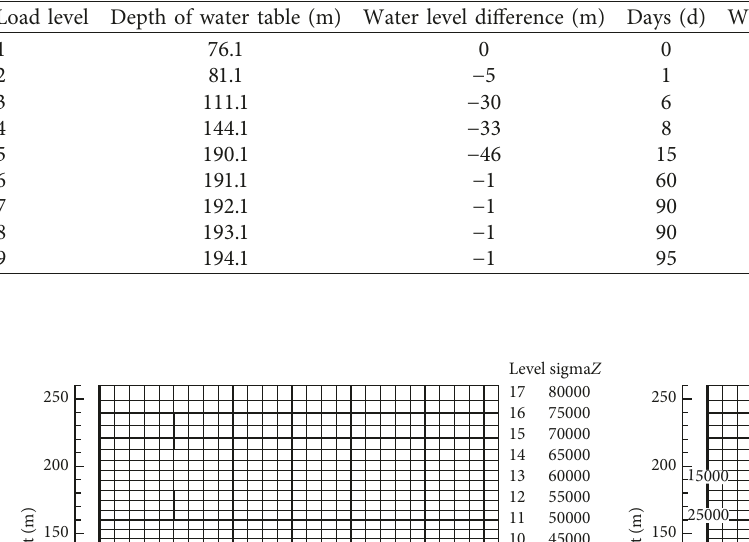
Table 3: The load level of the calculation